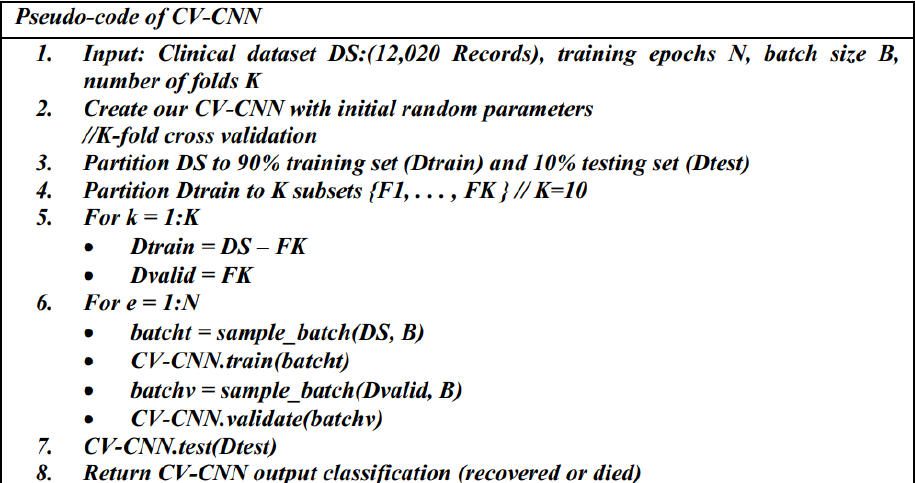
Figure 5. A schematic diagram of the CV-CNN model.